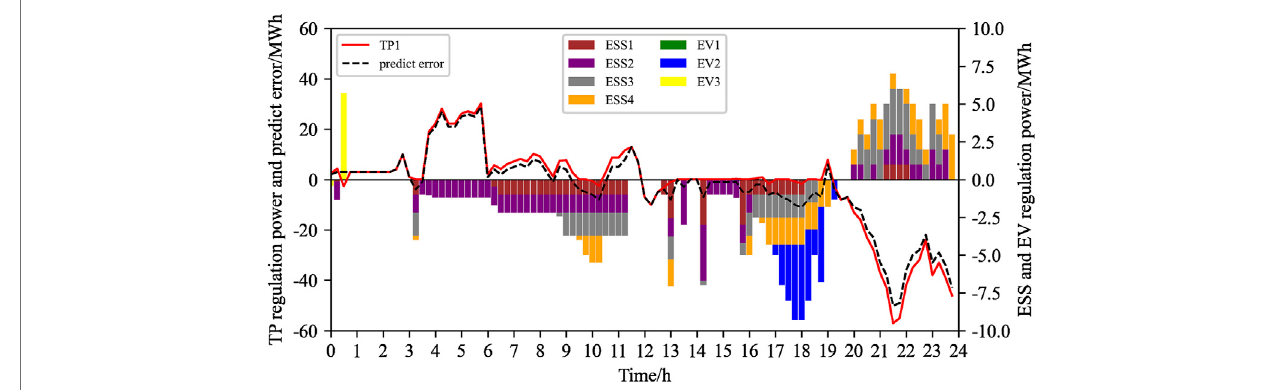
FIGURE 7 | Wind power consumption curve.